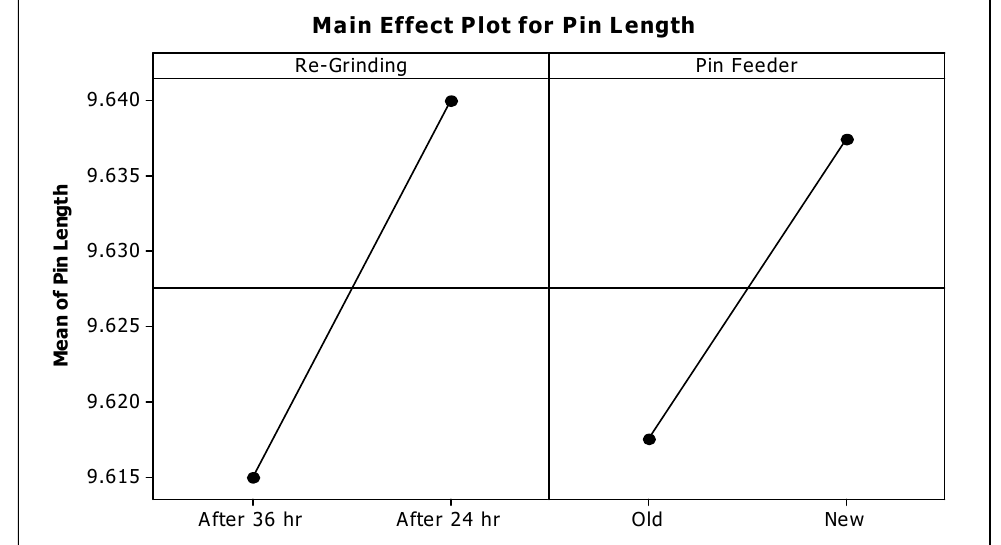
Fig. 6. Main Effect Graph for Pin Length